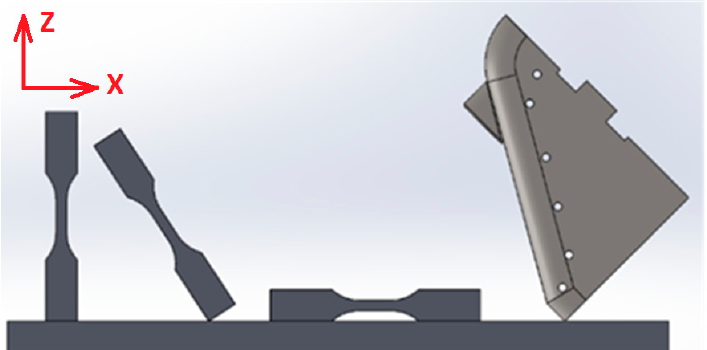
Figure 1. Orientation of samples on the building platform.